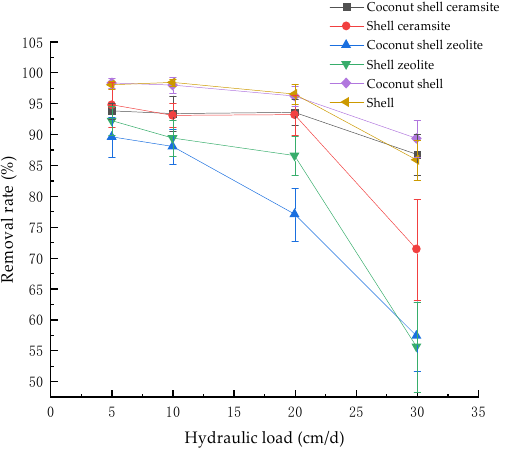
Figure 8. Removal effect of ammonia nitrogen in biochar-constructed wetland.